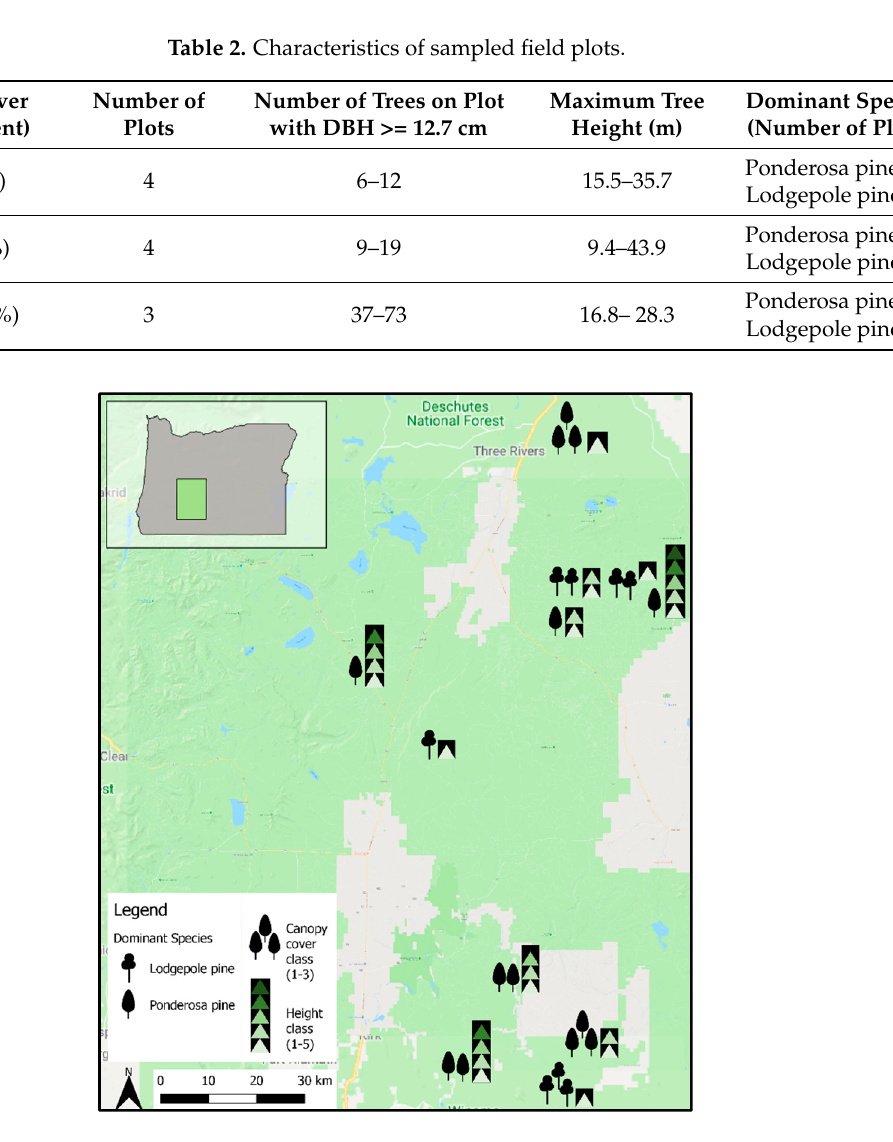
Figure 1. Location of field plots sampled from Carbon Monitoring System (CMS) in Oregon.